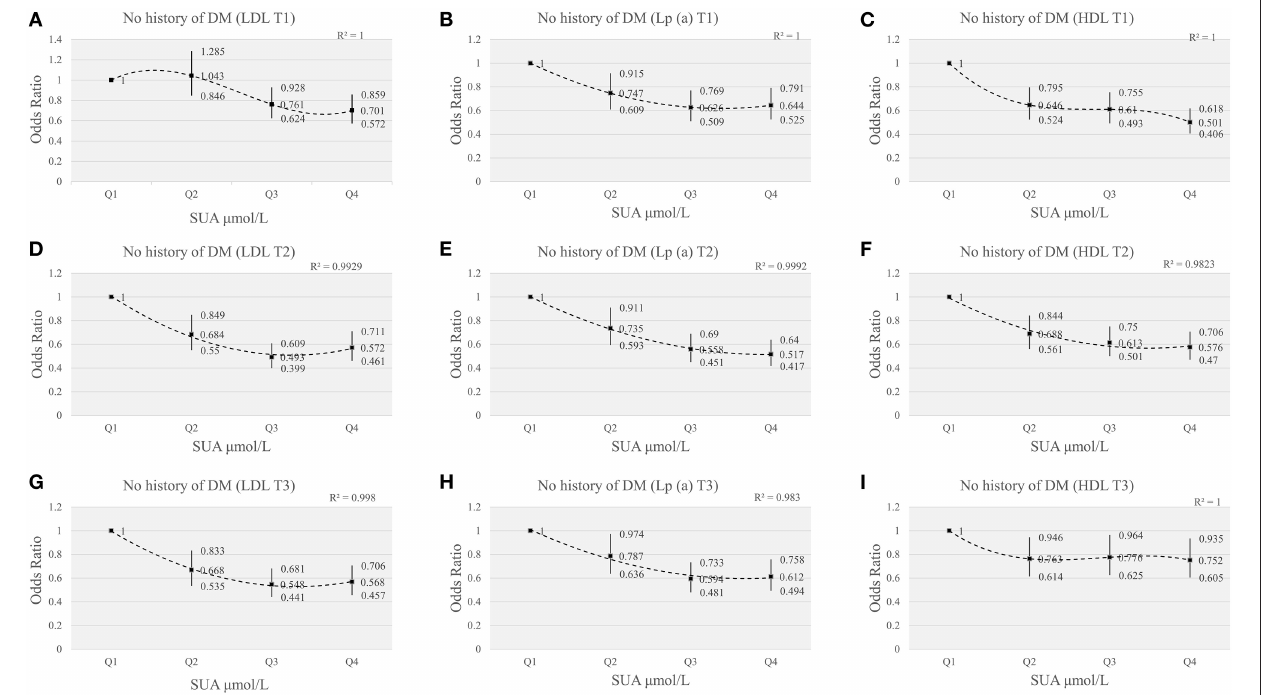
FIGURE 6 | The risk of myocardial revascularization based on SUA quartiles grouped by LDL/Lp(a)/HDL tertiles in ACS patients without DM. (A,D,G) adjusted for age, gender, smoking, HDL, TG, Glucose, Creatinine, Statin use, Hypertension; (B,E,H) adjusted for age, gender, smoking, HDL, LDL, TG, Glucose, Creatinine, Statin use, Hypertension; (C,F,I) adjusted for age, gender, smoking, LDL, TG, Glucose, Creatinine, Statin use,